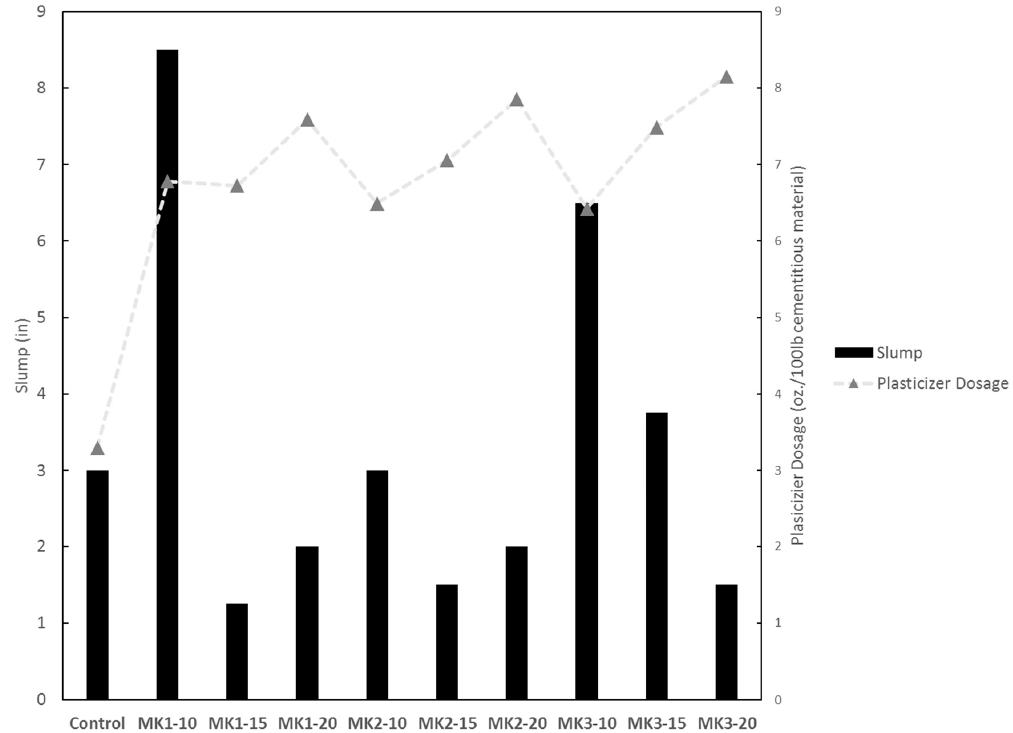
Figure 2. Slump and superplasticizer dosage for all mixtures.